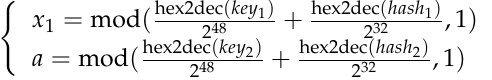
Figure 4. Flow chart of the image-encryption algorithm.